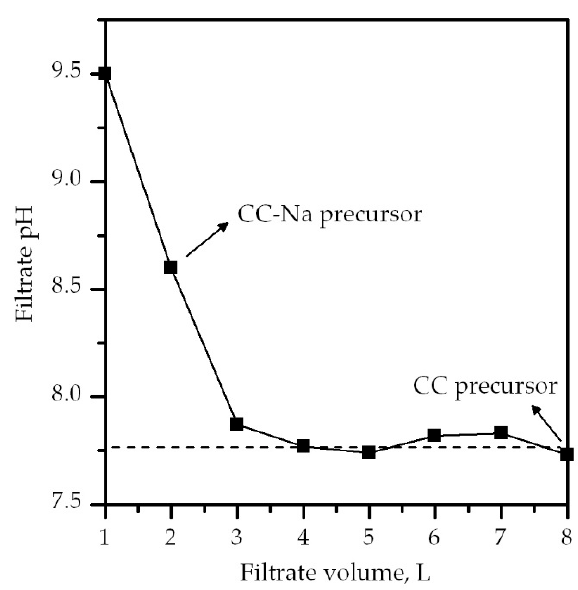
Figure 1. pH of the filtrate from the washing step of the catalytic precursors (CC and CC-Na).